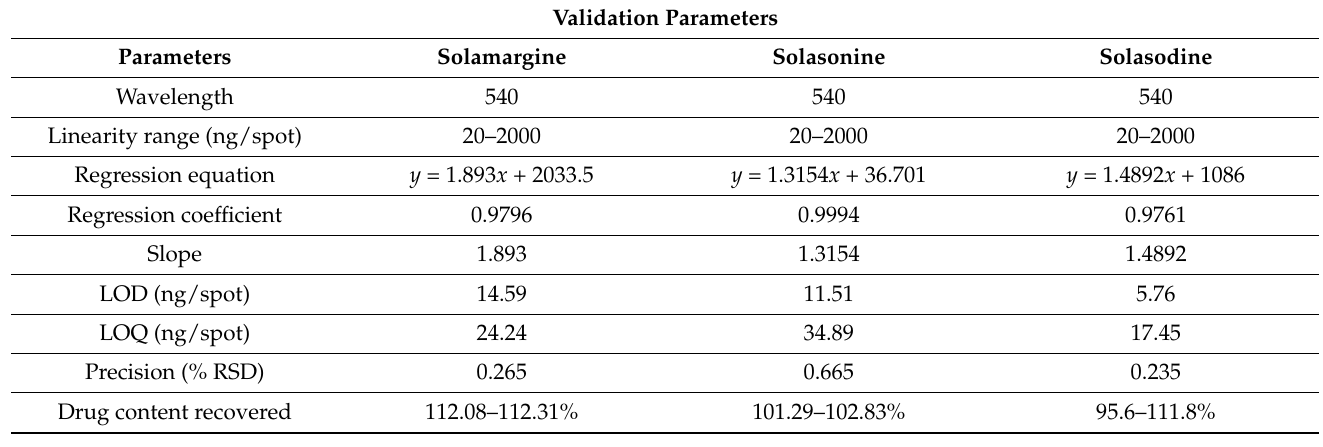
Table 2. Quantification and validation of Solamargine, Solasonine, Solasodine in different extracts of Solanum xanthocarpum Schrad. & Wendl.